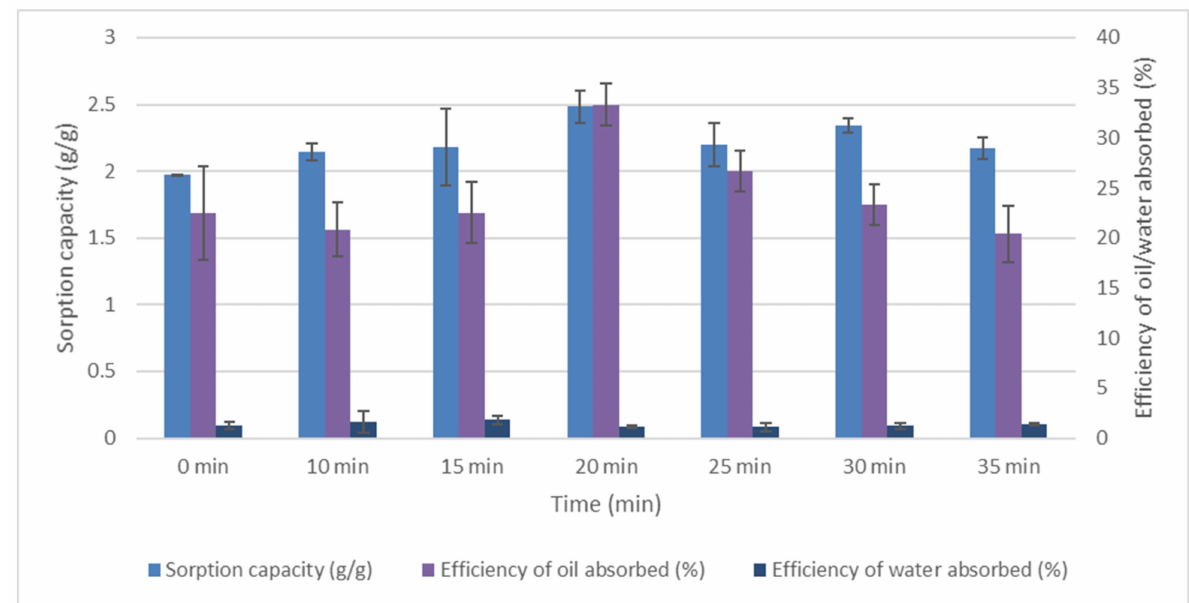
Figure 6. Effects of time on EFB treated fibre. Data obtained were the average efficiency of oil absorbed (%), the efficiency of water absorbed (%), and sorption capacity (g/g) on temperature. Vertical bars indicate SEM of three